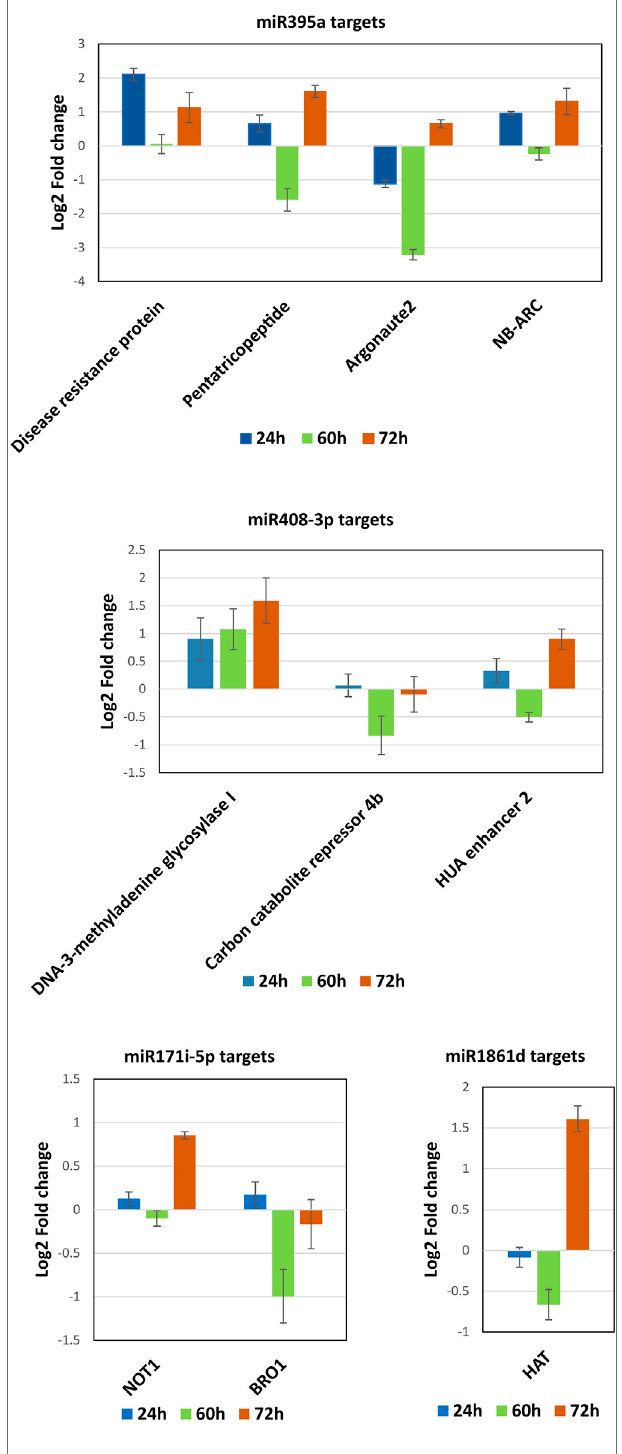
FIGURE 9 | MiRNAs target quanti fi cation. The possible mRNA targets for the miRNAs such as miR395a, miR408-3p, miR171i-5p, and miR 1861d weresubjectedtoqRT-PCRtoquantifyandcorrelatetheexpressionbetween miRNA and mRNA at 24, 60, and 72 hpi of R. solani infection with respect to control